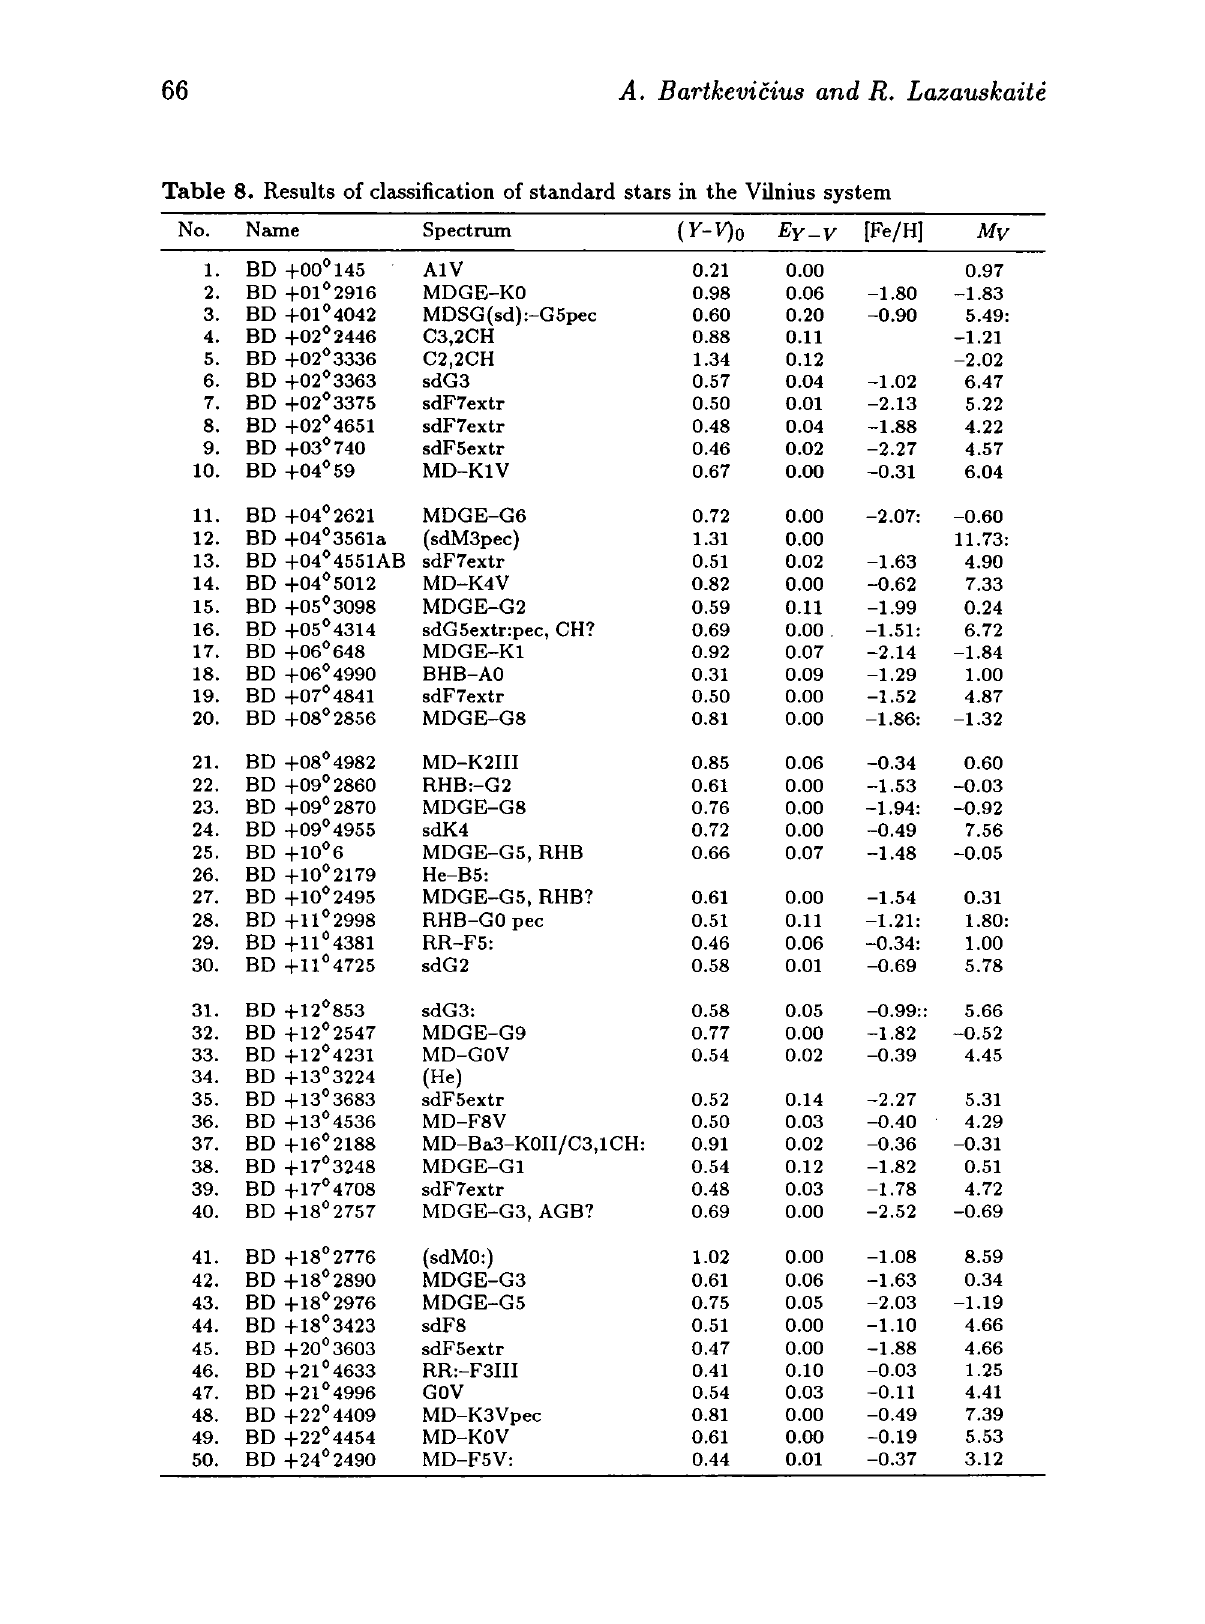
Table 8. Results of classification of standard stars in the Vilnius